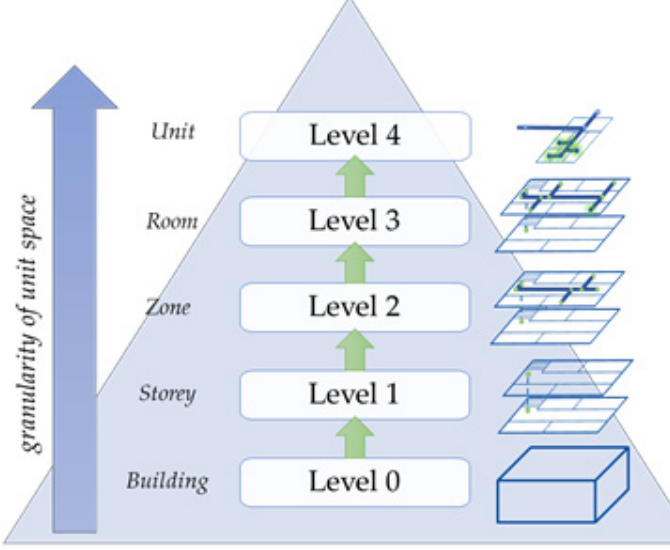
Figure 7. Spatial hierarchy applied to network LOD.